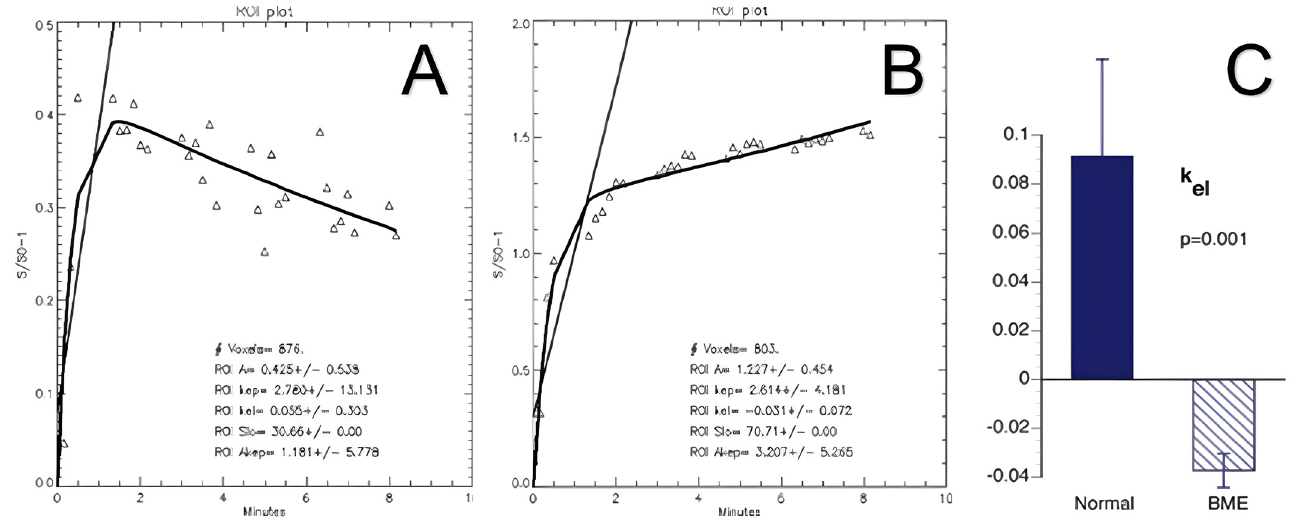
Figure 3. MRI time–intensity curves displaying inflow and outflow of Gd contrast agent. Gd concentration is proportional to blood flow and reflects perfusion. ( A ) In normal bone, outflow begins at 2 min of scan time and is completed within 10 min. ( B ) In BME, concentration continues to rise as outflow is obstructed (venous stasis). Pharmacokinetic modeling with the Brix equation allows quantification of the flow curve characteristics through derivation of perfusion constants. ( C ) k el represents the contrast elimination constant and reveals quantitative differences in venous outflow between normal bone and BME. Adapted with permission from Ref. [16]. 2007, Annals of the New York Academy of Sciences .